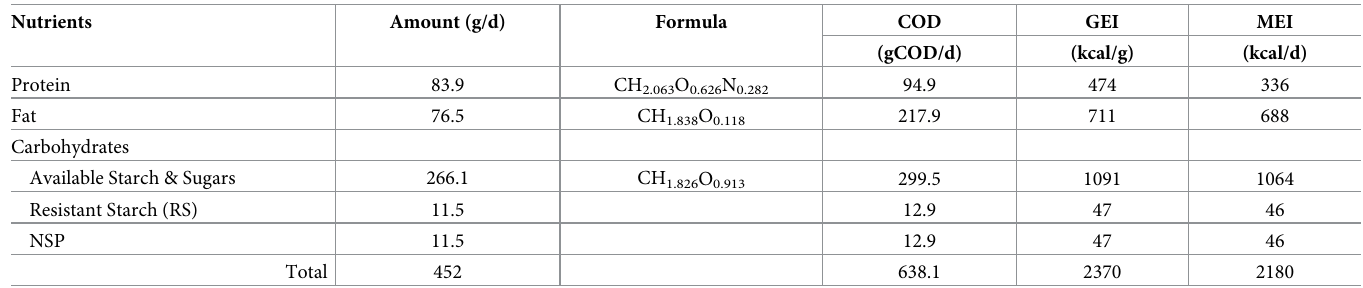
Coefficients for Gross Energies are 4.1 kcal/g for carbohydrates, 5.65 kcal/g for proteins, and 9.3 kcal/g for fat [21, 24]. Metabolizable energies are 4 kcal/g for carbohydrates, 4 kcal/g for proteins, and 9 kcal/g for fat. Abbreviations are COD—Chemical Oxygen Demand; GEI–Gross Energy Intake; and MEI–Metabolic Energy